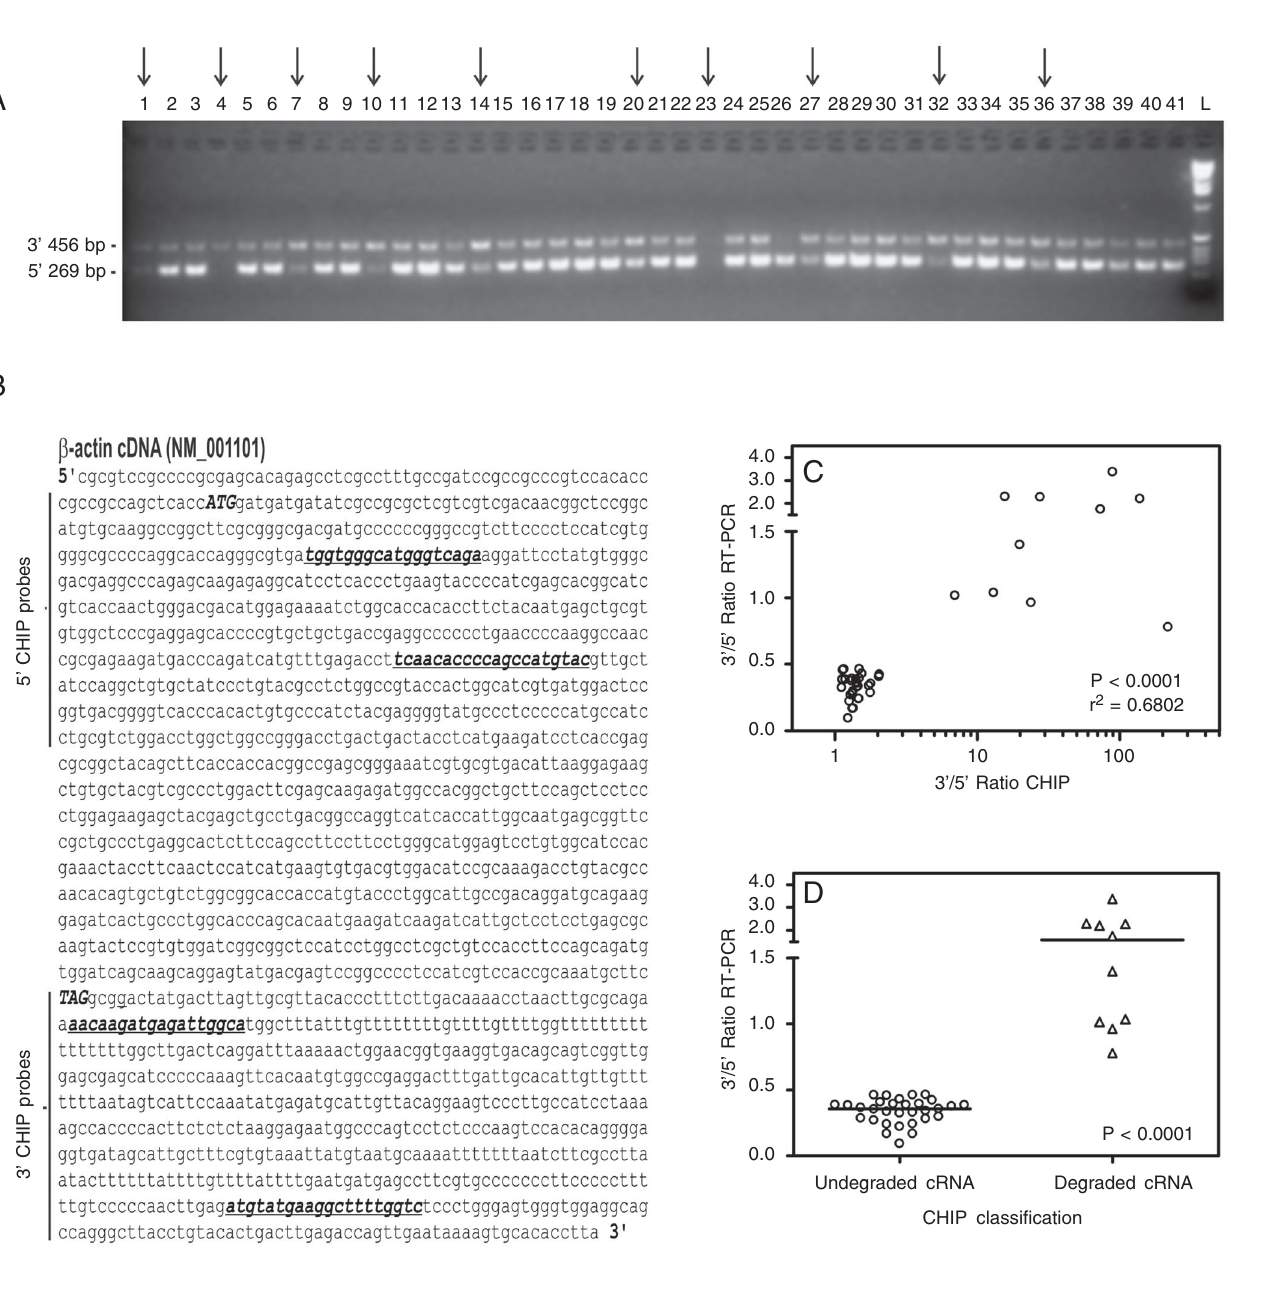
Figure 1. cRNA quality assessment by the analysis of ß-actin 5' and 3' sequence abundance using a duplex RT-PCR in comparison to the microarray- obtained 3'/5' ratio. A , RT-PCR products (sample 1 through 41) were analyzed on a 2% agarose gel stained with ethidium bromide. The 3' ß-actin (456 bp) and the 5' ß-actin (269 bp) PCR products were detected. L = 1 Kb DNA ladder (Invitrogen, Carlsbad, CA, USA). Arrows show samples classified as degraded by the microarray result. B , ß-actin cDNA sequence. ATG and TGA correspond to the translation start and termination codons, respectively. Sequence regions targeted by the array 3' and 5' probes are depicted. Underlined sequences correspond to the location of primers used for PCR. C , The optical density of each band was measured and the 3'/5' ratio was calculated and plotted against the respective 3'/5' ratio assessed by the Affymetrix HG-U133A microarray (CHIP) analysis. CHIP 3'/5' ratios were transformed into logarithmic values for correlation analysis (Pearson test). D , The RT-PCR 3'/5'ratios of samples classified as undegraded (CHIP 3'/5' ratio <6) and degraded (CHIP 3'/5' ratio >6) are shown. Significance was calculated using the Student t